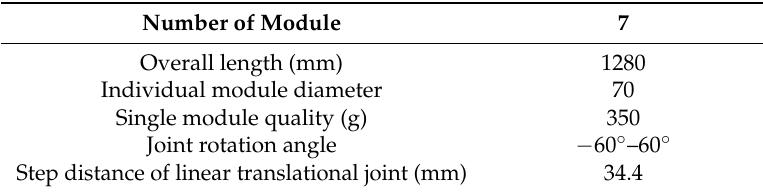
Table 2. Parameters of the snake-like